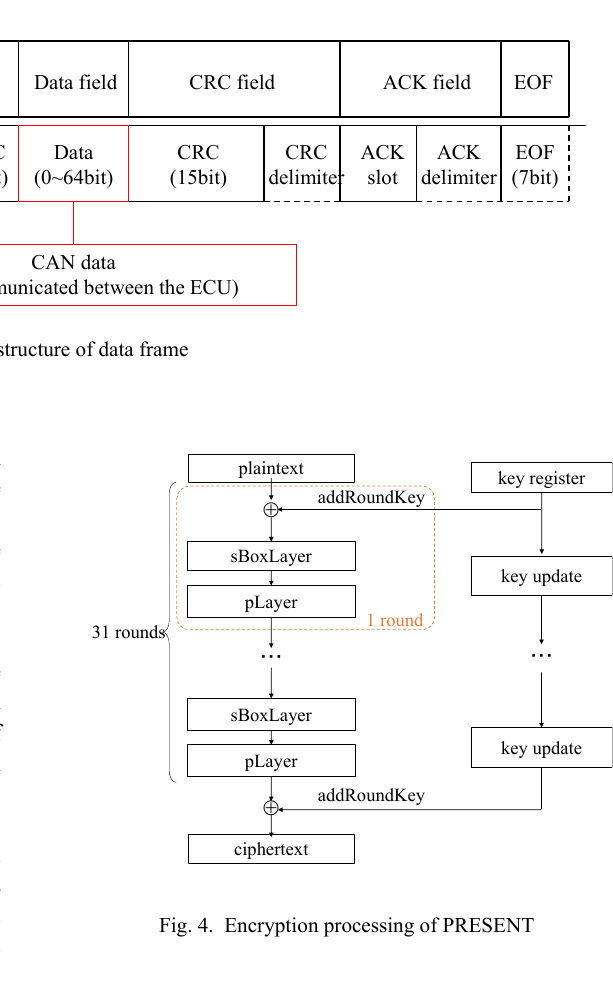
Table 1. The sBoxLayer and pLayer